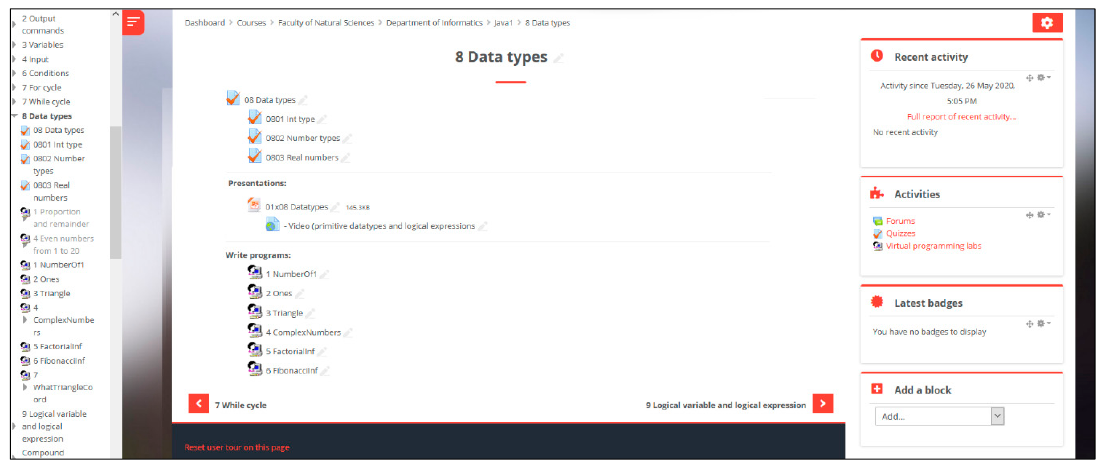
Figure 2. The view of the chapter Data types in the English version of the course of 2019/2020. It consists of quizzes, presentation file, link to the video placed on YouTube and automated source code evaluation activities.